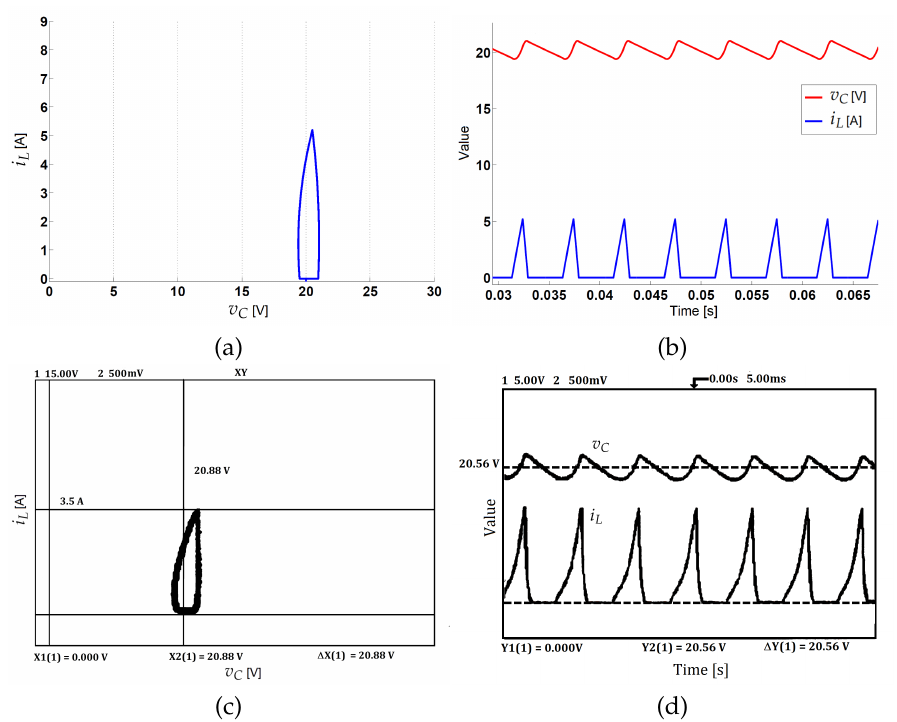
Figure 26. Experimental validation of voltage control using the constant hysteresis control for ξ = 1 V, converging to 1 T -periodic orbit in DCM: ( a ) phase portrait, ( b ) time evolution for simulation results, ( c ) phase portrait, and ( d ) time evolution for experimental